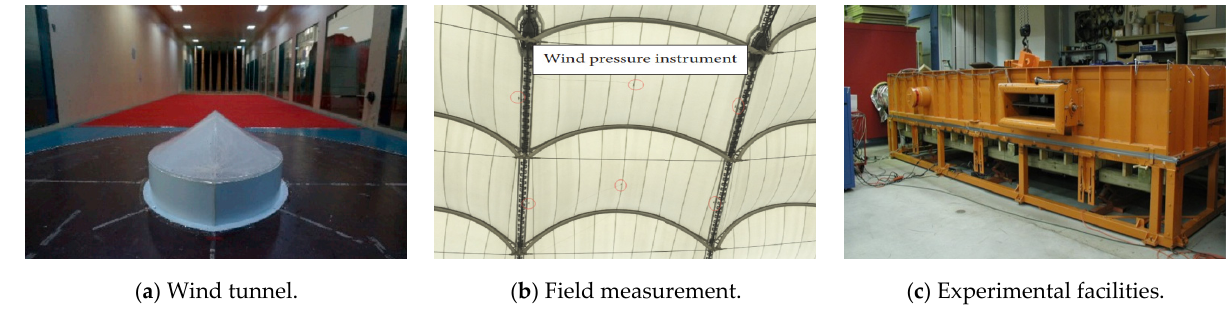
Figure 9. Experimental methods of structural wind load response research [14,58,59].